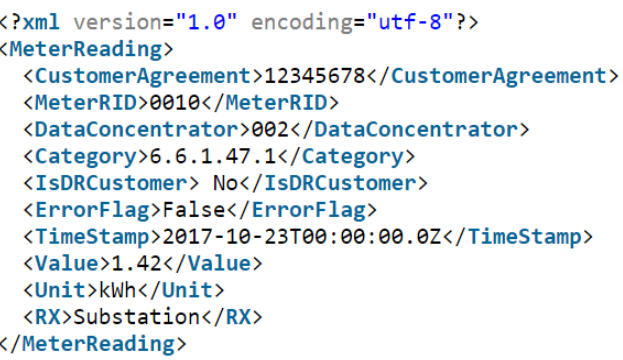
Figure 4. An example of the XML load measurement from a smart meter.